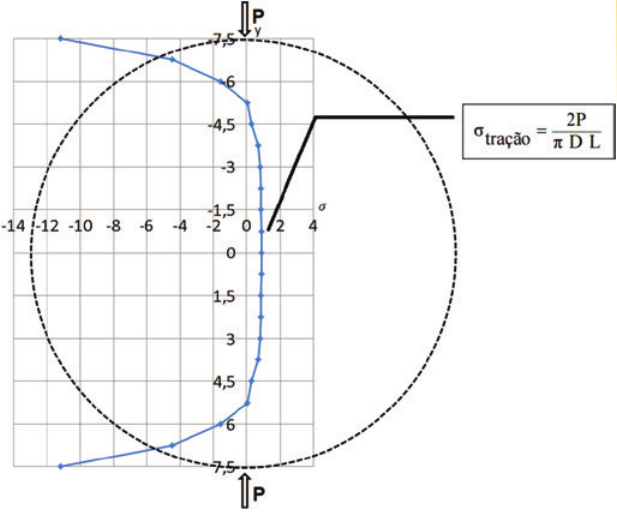
along the y axis x